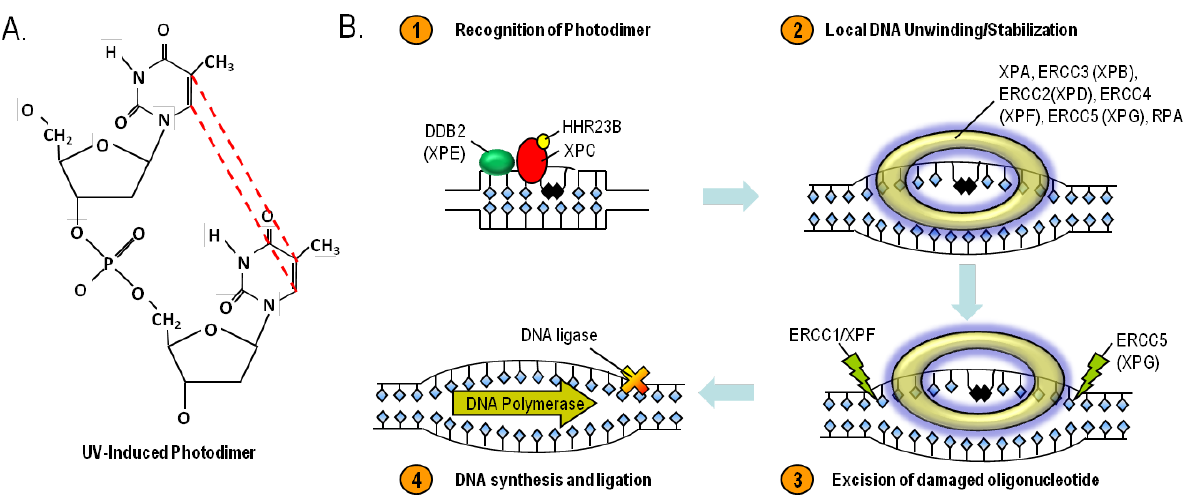
Figure 6. UV-induced cyclobutane dimers- structure ( A ) and repair by the Nucleotide Excision DNA Repair (NER) pathway ( B ). The NER pathway is mediated by at least eight enzymes that work together to identify bulky DNA lesions that distort the structure of the double helix, excise the damaged portion and replace the excised region by DNA synthesis directed by the complementary strand. Homozygous deficiency in any one of the NER enzymes leads to the clinical condition known as Xeroderma Pigmentosum (XP). Although not shown, NER can also be initiated in actively transcribed regions of the genome by involvement of the Cockayne syndrome proteins A and